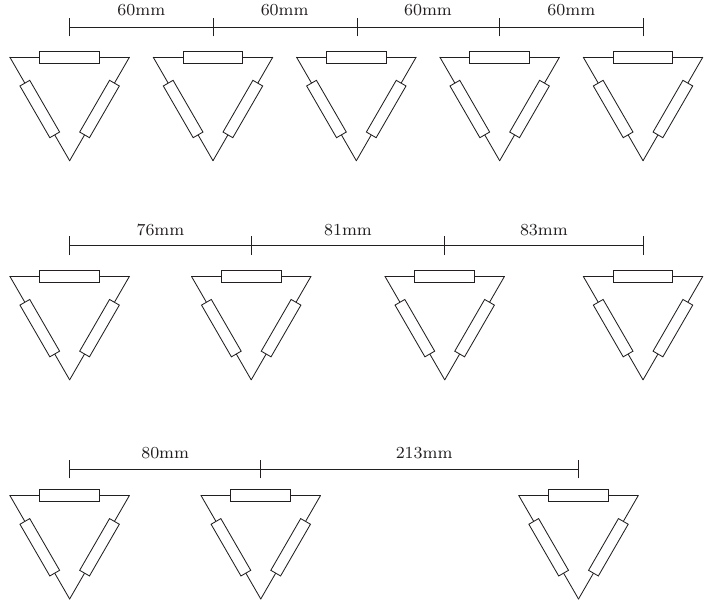
Figure 5. Comparison between the initial five-rosette strain gauge array and the optimised four- rosette and three-rosette